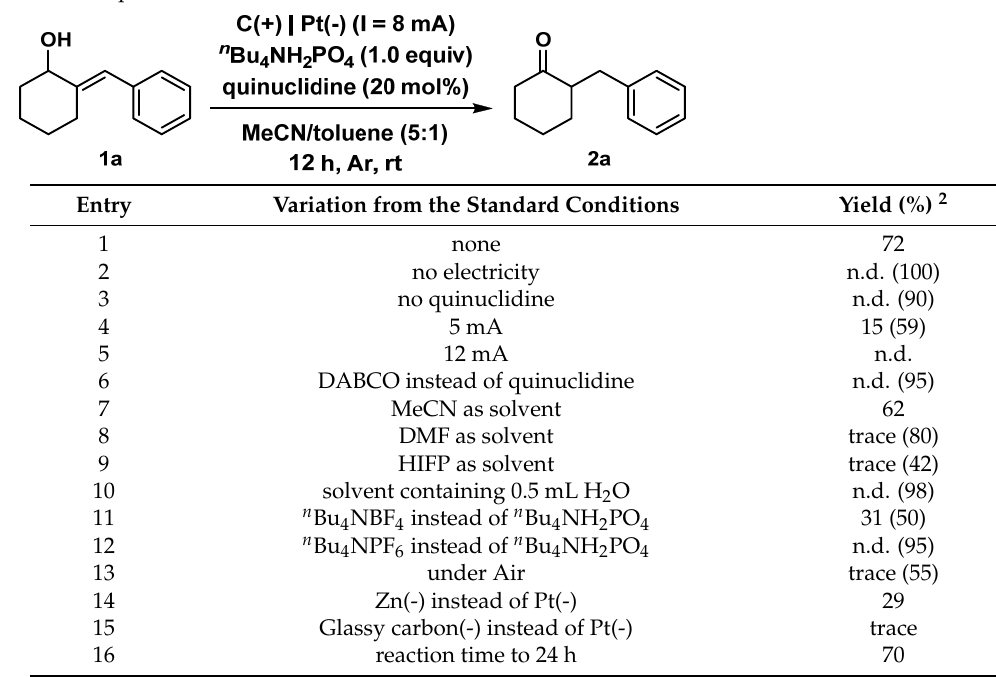
Table 1. Optimization of the reaction conditions 1 .